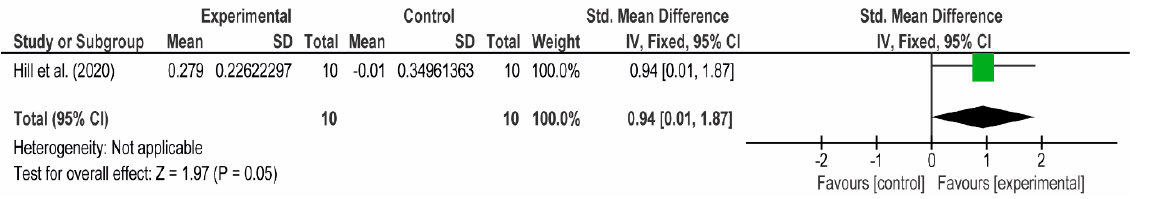
Figure 15. The effect size of 4-weeks of concentric low-load (at 30% of concentric elbow flexion peak Figure 15. The effect size of 4- weeks of concentric low-load (at 30% of concentric elbow flexion peak Figure 15. The effect size of 4- weeks of concentric low-load (at 30% of concentric elbow flexion peak Figure 15. The effect size of 4- weeks of concentric low-load (at 30% of concentric elbow flexion peak Figure 15. The effect size of 4- weeks of concentric low-load (at 30% of concentric elbow flexion peak torque) forearm flexion-extension training with vBFR (40% of lowest pressure needed to restrict torque) forearm flexion-extension training with vBFR (40% of lowest pressure needed to restrict torque) forearm flexion-extension training with vBFR (40% of lowest pressure needed to restrict torque) forearm flexion-extension training with vBFR (40% of lowest pressure needed to restrict torque) forearm flexion-extension training with vBFR (40% of lowest pressure needed to restrict brachial artery) on increasing the biceps brachii CSA. brachial artery) on increasing the biceps brachii CSA. brachial artery) on increasing the biceps brachii CSA. brachial artery) on increasing the biceps brachii CSA. brachial artery) on increasing the biceps brachii CSA.